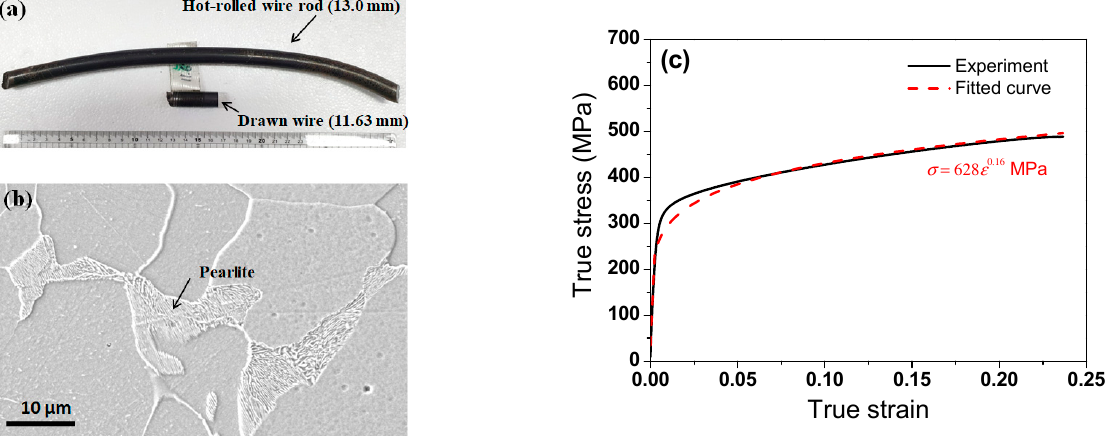
Figure 2. ( a ) Photograph of obtained hot-rolled wire rod steel, ( b ) its microstructure, and ( c ) true stress–strain curve in tensile test.